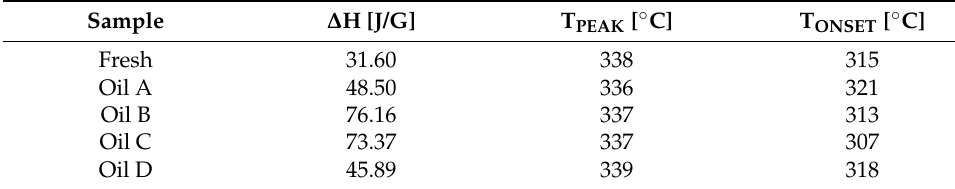
Table 5. DSC results for the PEEK samples (fresh and aged in the ATFs). Sample